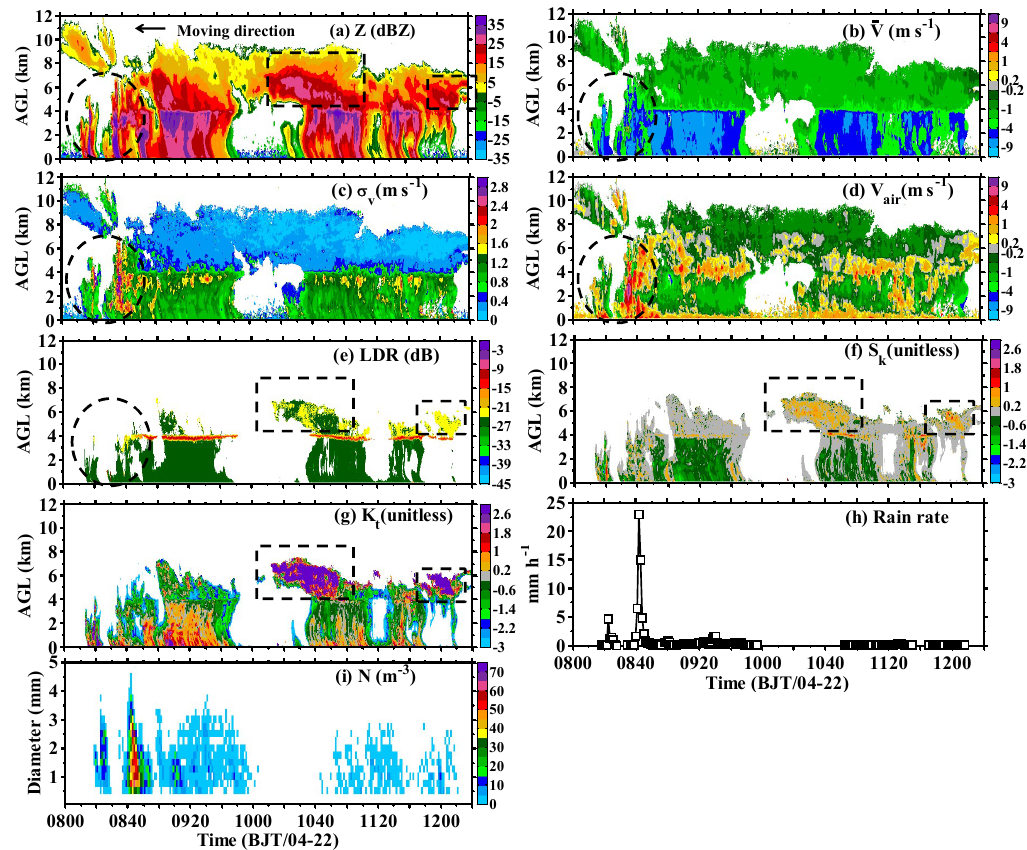
Figure 8. Time–height cross-sections of the MMCR measurements and the Parsivel-measured rain rate and DSD on the ground for a squall line convection that occurred over the site between 08:00–12:20 BJT on 22 April. ( a )–( g ) are radar reflectivity, mean Doppler velocity, spectrum width, vertical air velocity, linear depolarization ratio, spectral skewness, and spectral kurtosis; (h) and (i) are ground rain rate and drop size distribution.